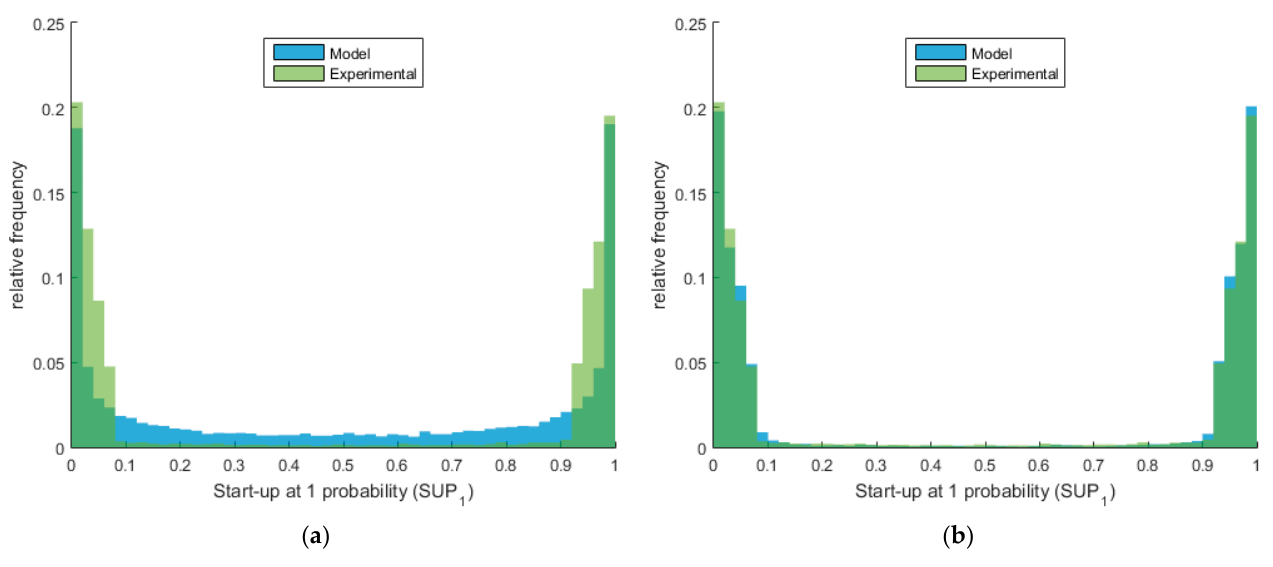
Figure 8. Histogram of the relative frequency of cells as a function of the SUP 1 (start up at logic ‘1’ probability) obtained from both experimental data and from modeled simulation results using: ( a ) Equation (3) with the fitted parameter of Equation (4) ( k = 195.4 V − 1 ), and a = 1; ( b ) Equation (6) with the fitted parameters of Equation (7) ( m = 0.158; k 1 = 101.2 V − 1 ; k 2 = 2348 V − 1 ).